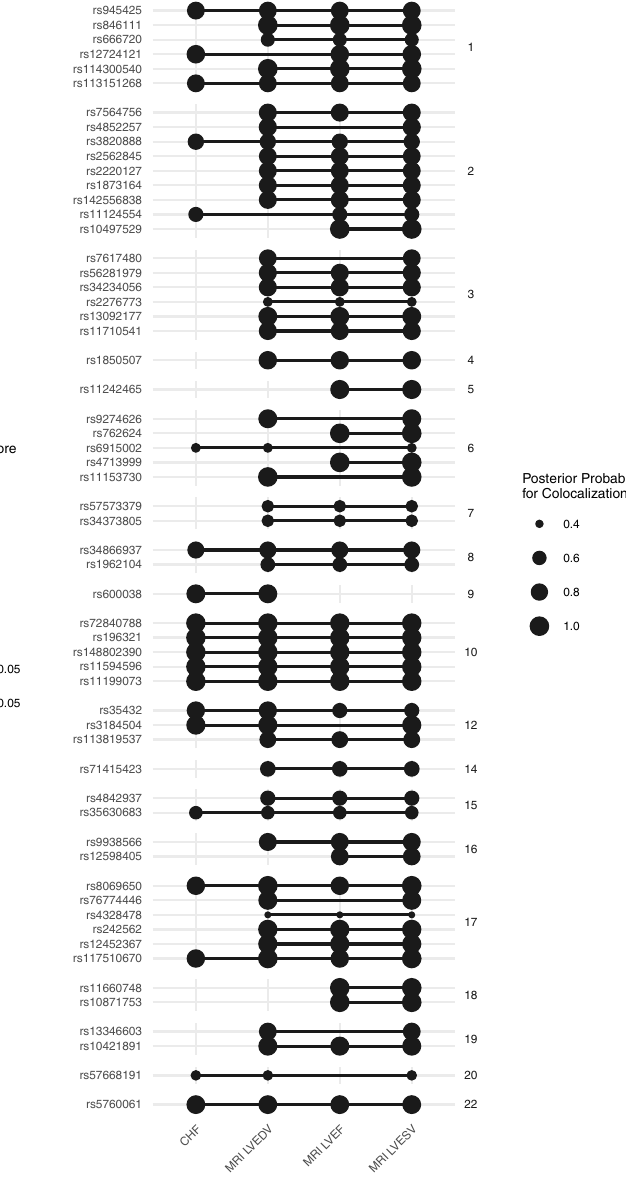
Fig. 5 | Results of multivariate genome wide association study. Multivariate GWAS and multi-trait colocalization were performed to identify genetic loci asso- ciated with HF and cardiac structure/function traits. A Results of multivariate GWAS. The x -axis denotes the multivariate GWAS method, and the y -axis denotes the independent lead variants at each locus. The size of each point denotes the absolute z -score for each trait. The shading of each point denotes whether the associationmetanFDRadjustmentformultipletesting.Associationsexceedingthe conventional genome-wide signi fi cance threshold are denoted with a white circle.